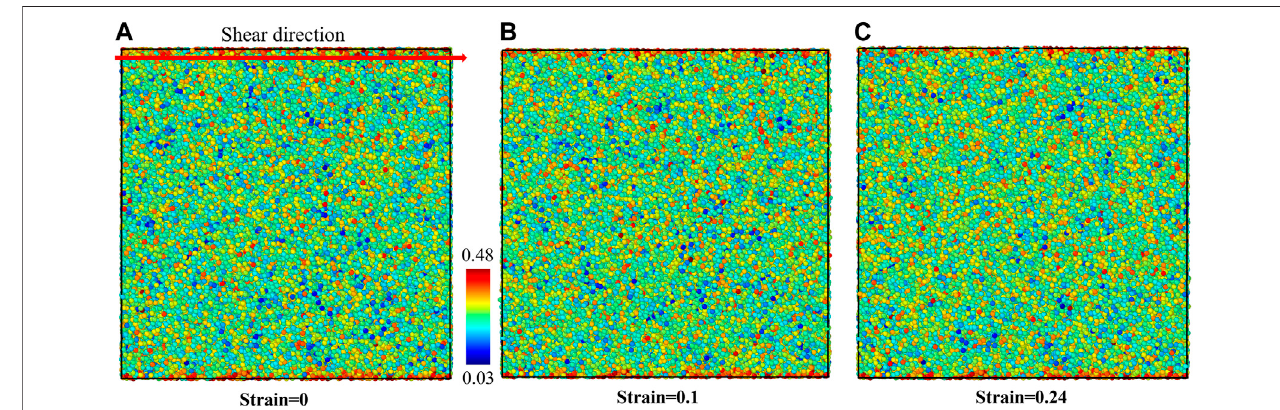
FIGURE 10 | The structural evolution of L-phase under shear deformation characterized using OP-8 order parameter. (A) The intact structure, (B) the structure at 0.10 shear strain before initiation of shear band, and (C) the structure at 0.24 shear strain after forming the shear band.